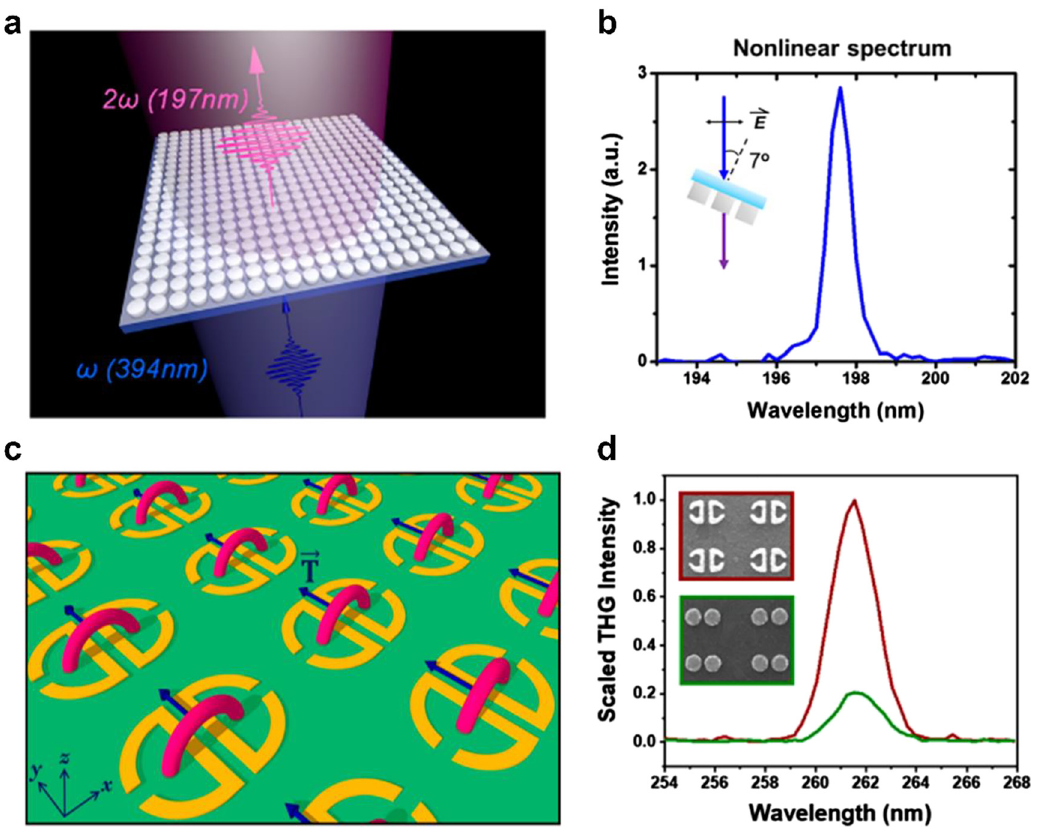
Figure 12: Nonlinear UV metasurfaces. (a and b) Second harmonic generation (a) by using the ZnO-based metasurfaces and the yielded SHG intensity (b). Semmlinger et al. [116]. © 2018 American Chemical Society. (c) Third harmonic generation assisted by the toroidal dipole to enhance the THG signal (c). (d) A comparison between the THG signals created by the toroidal meta-atoms (red) and nanodisk (green) dimers. Ahmadivand et al. [43]. © 2019, American Chemical